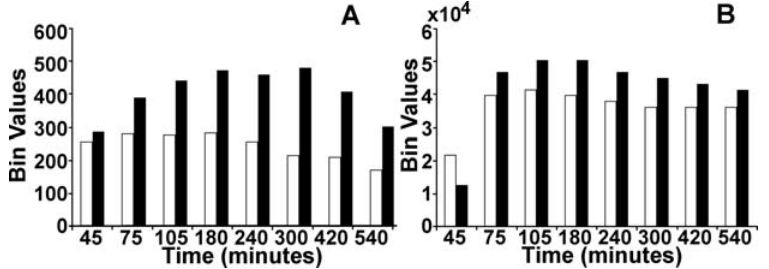
Figure 8. Modal bin values of GFP distribution with time: A) Experimental, and B) Theoretical distributions for the Basic (TG– white bar ) and Delay (C2TG– Black bar ) circuits.